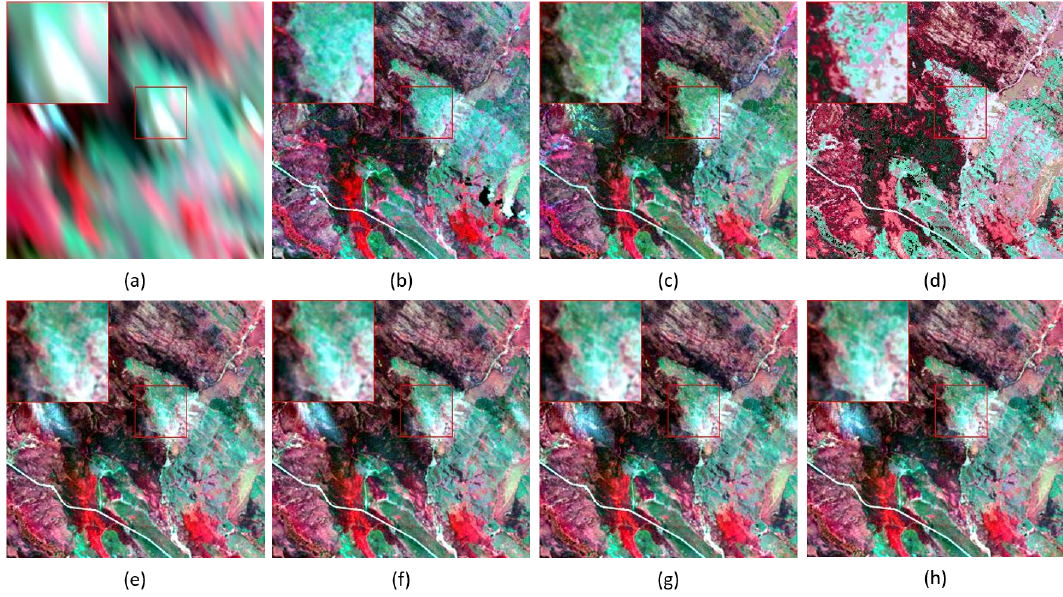
Figure 3. Comparisons between the true image 2 and images reconstructed by different fusion methods. ( a ) MODIS; ( b ) true Landsat image; ( c ) ESTARFM; ( d ) CRSU; ( e ) SPSTFM; ( f ) EBSCDL; ( g ) AMCFM; ( h )